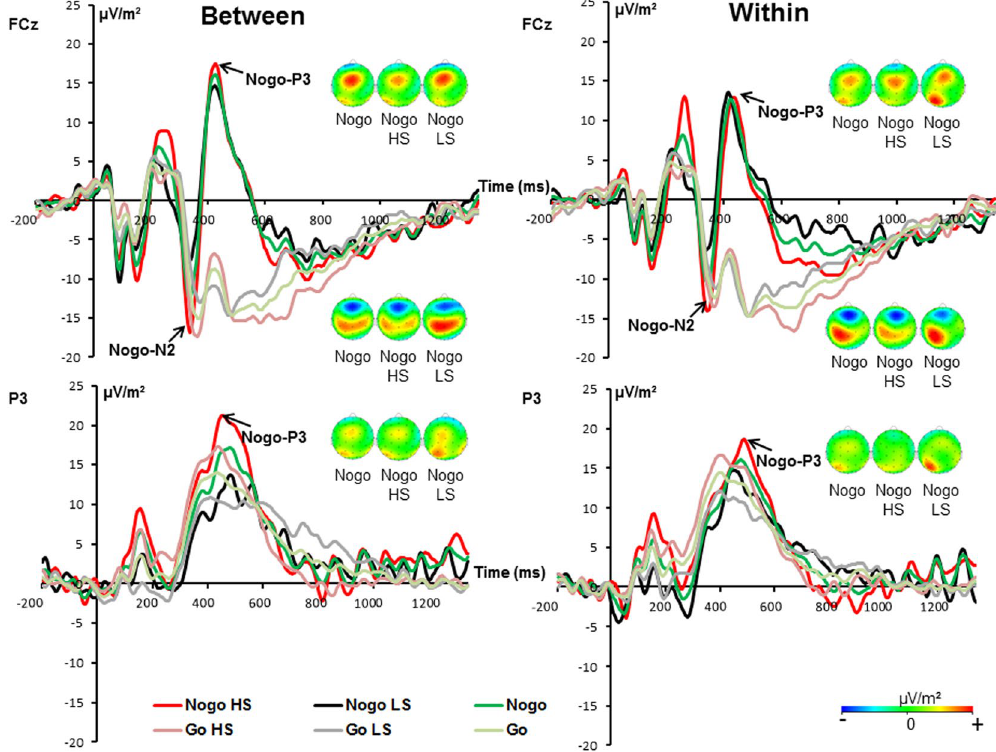
Figure 2. The P3 and N2 ERP components shown at electrode FCz (on top) and at electrode P3 (at the bottom) for the within-hand and the between-hands condition in GO and NOGO trials. In all plots time point 0 marks stimulus presentation. The different colors of the ERP traces correspond to the different experimental conditions as shown in the legend for GO and NOGO trials in the high (HS) and the low (LS) suppression group. The scalp topography plots represent the N2 and P3 in NOGO trials for the different conditions at the peak of the respective component. Red represents positive values and blue negative